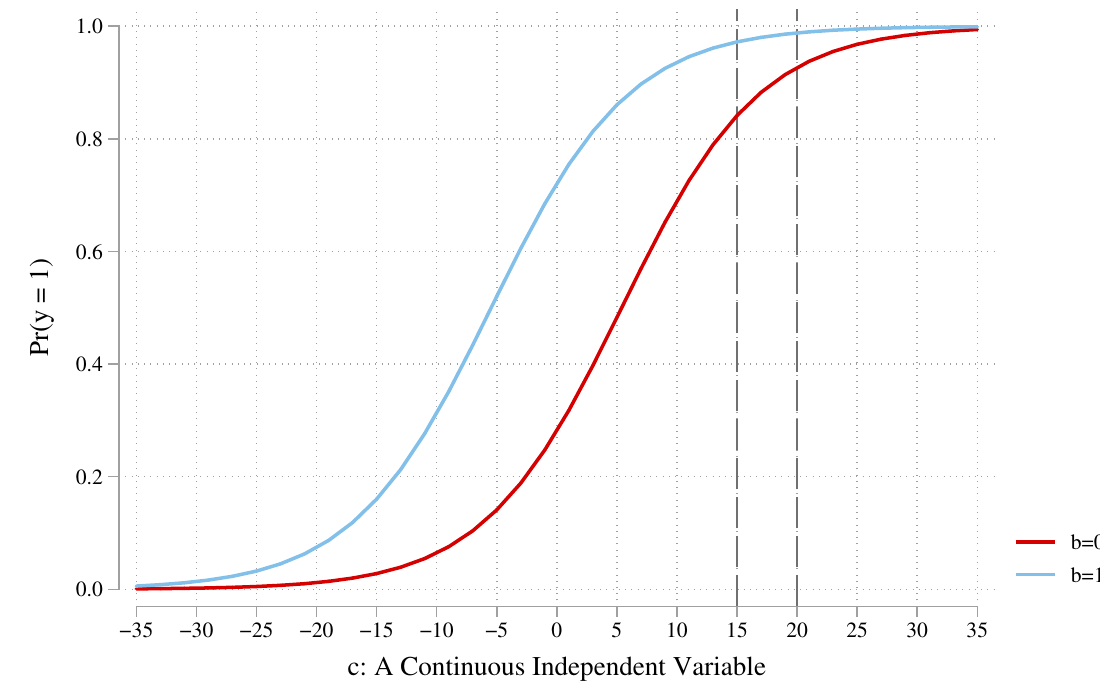
Figure 5: Simulated data: effect of an intercept shift in binary logistic